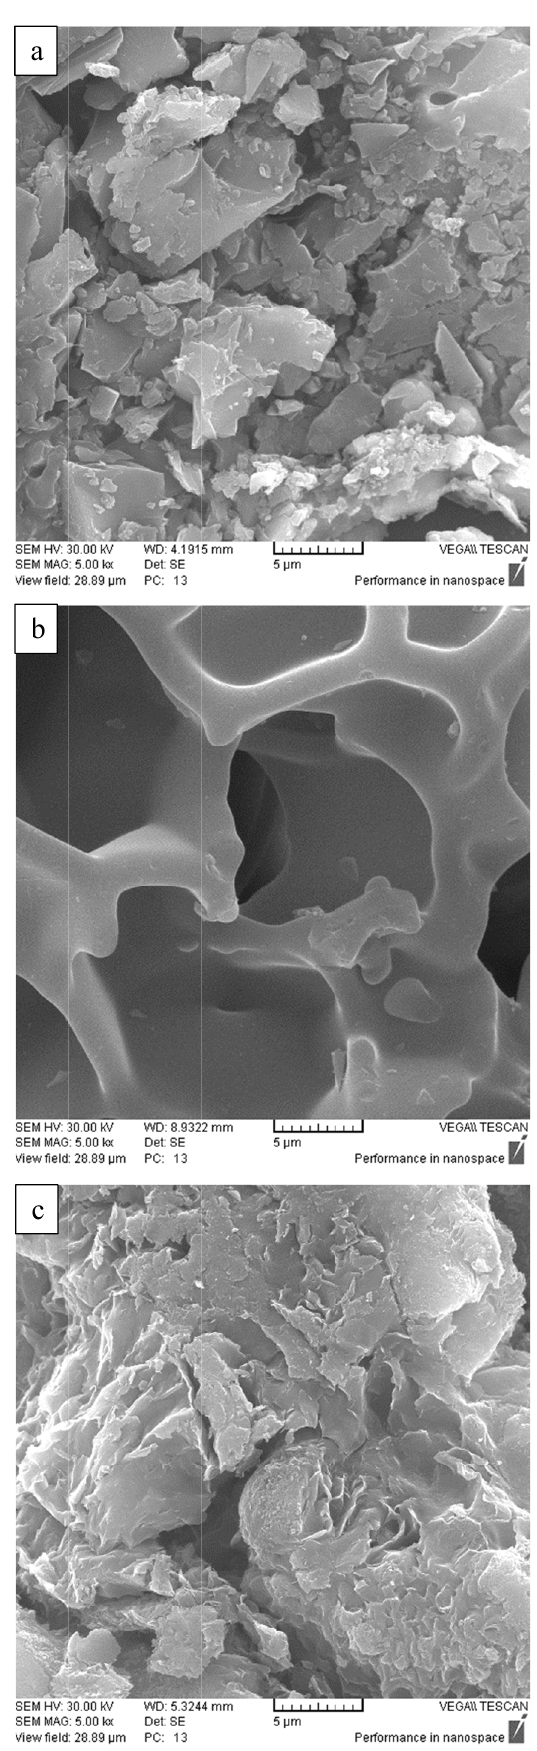
Fig. 3. SEM images of a) UP, b) EP and c) NaOH-UP (magnifications: